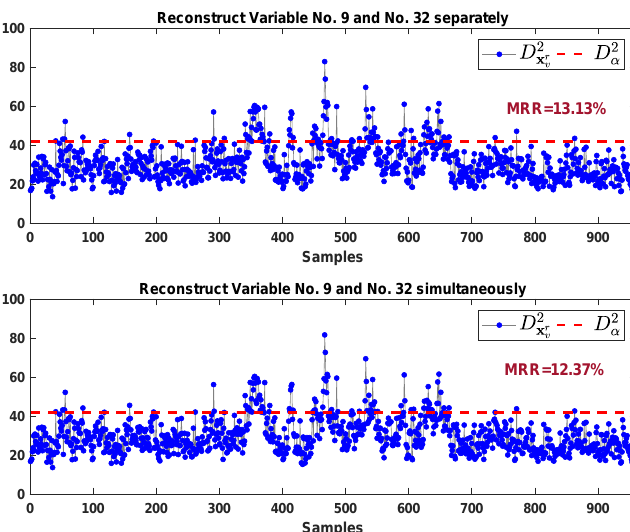
Figure 18. The fault detection results of reconstructed samples by estimating and replacing variable No.32 and No.9 for fault 11 of